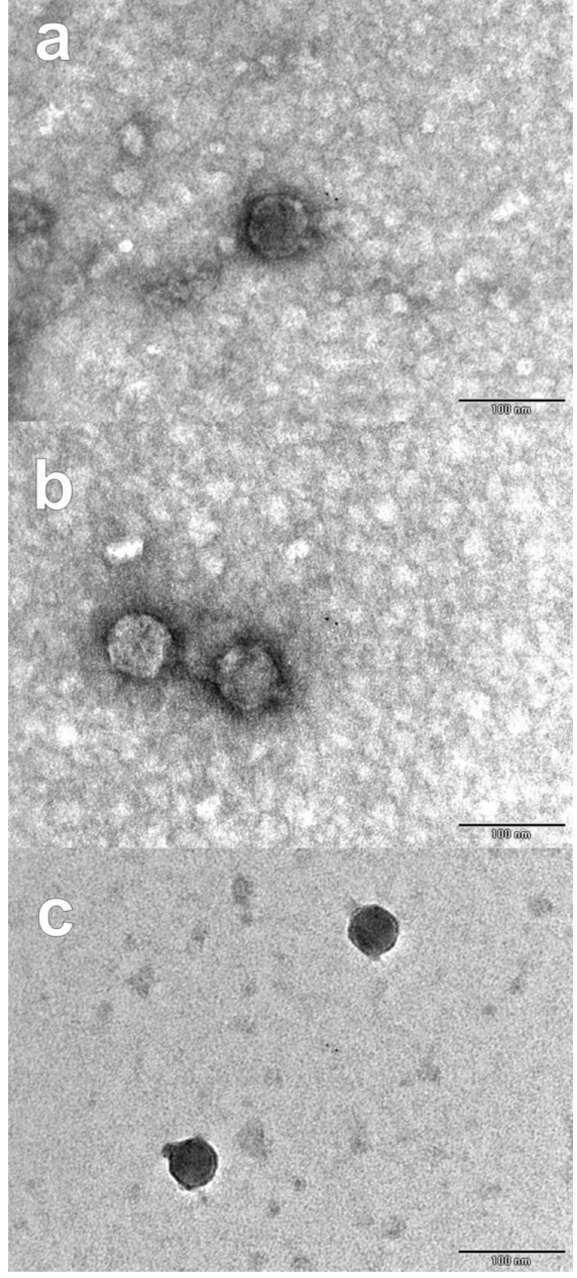
Figure 2. TEM micrographs of bacteriophages PL-01 ( a ), GB-02 ( b ), and GB-03 ( c ) isolated from poultry liver and ground